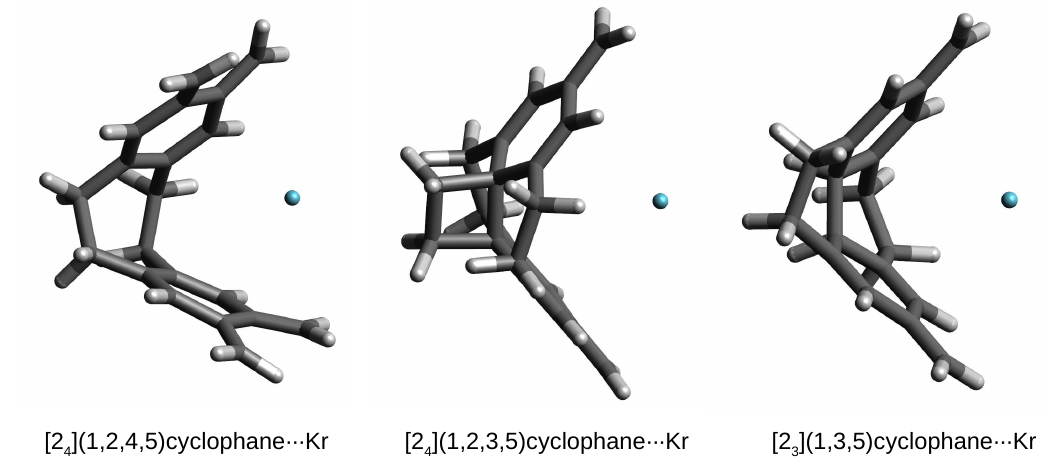
Figure 9. Structures of some cyclophane · · · Kr